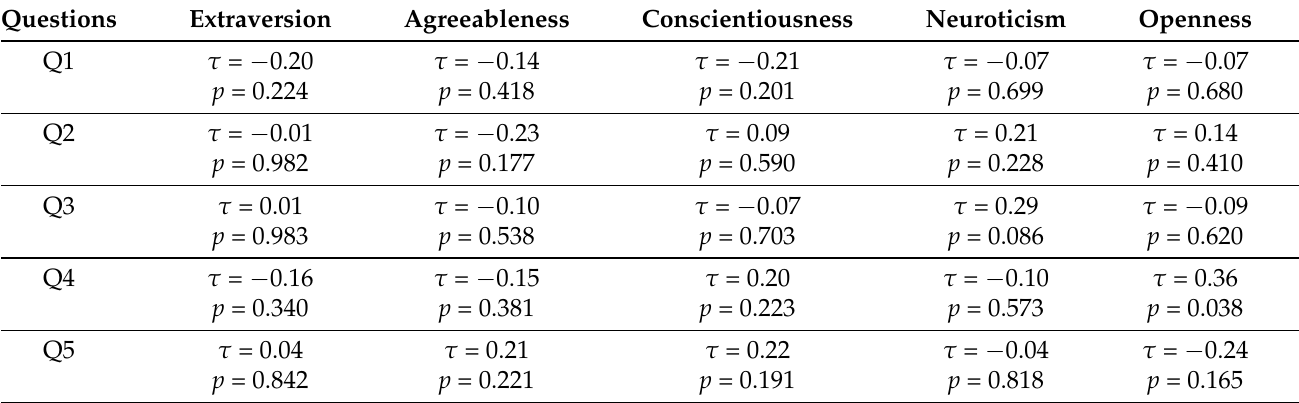
Table A6. Kendall correlations between participants’ personality traits and their responses to questions Q1 through